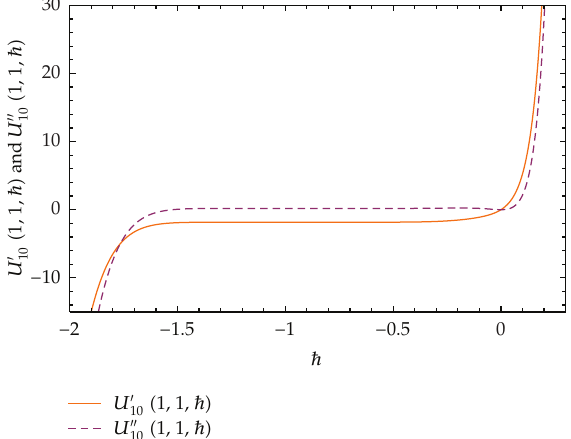
Figure 7: The ℎ curves of 𝑈 󸀠 10 (1, 1, ℎ) and 𝑈 󸀠󸀠 10 (1,1, ℎ) for C - S